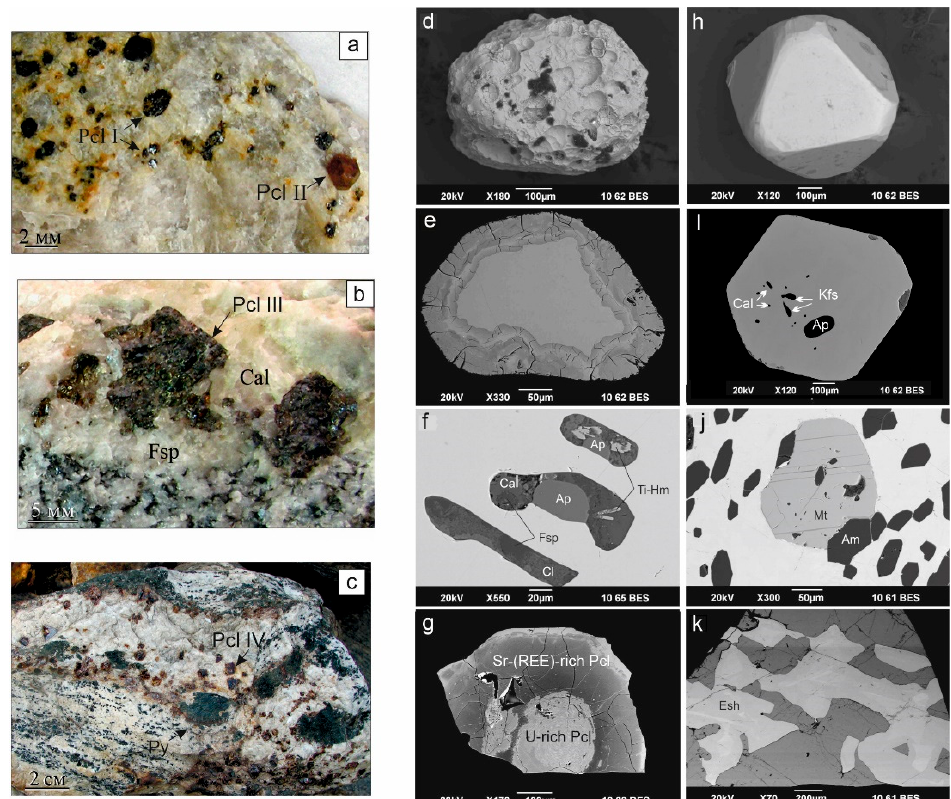
Figure 3. Morphology and inner structure of pyrochlore crystals from carbonatite complexes of the Urals. ( a – c ) photo: V.A. Popov [94]. Ilmeno–Vishnevogorsk complex: ( a ) black and light-brown pyrochlore grains and crystals in miaskite-pegmatite, Vishnevogorskoe Nb-deposit; ( b ) pyrochlore crystals with biotite (Bt) and calcite (Cal) in carbonatite veins (sövite II), ore zone 140, Vishnevogorskoe deposit; ( c ) pyrochlore crystals in feldspar-pyroxene vein fenite, ore zone 125, Vishnevogorskoe deposit; ( d ) grain of U-(Ta)-pyrochlore with spherical cavities (sövite I), Potaninskoe deposit; ( e ) inner structure of hydrated U-(Ta)-pyrochlore (sövite I); ( f ) multiphase inclusions in the grain of fluorocalciopyrochlore (sövite I); ( g ) inner structure of a pyrochlore crystal: a relict core composed of U-containing pyrochlore (light-gray in the BSE) bordered by (Sr-REE)-pyrochlore (dark gray) (sövite II, Vishnevogorskoe deposit); ( h , i ) cuboctahedral crystal of (Sr-REE)-pyrochlore with inclusions of calcite, apatite, feldspar (sövite II, Vishnevogorskoe deposit). Buldym complex: ( j ) pyrochlore crystals with numerous inclusions of amphibole and magnetite from phlogopite-richterite metasomatites; ( k ) pyrochlore in intergrowth with aeshinite, Buldym deposit. Py—pyroxene, Am—